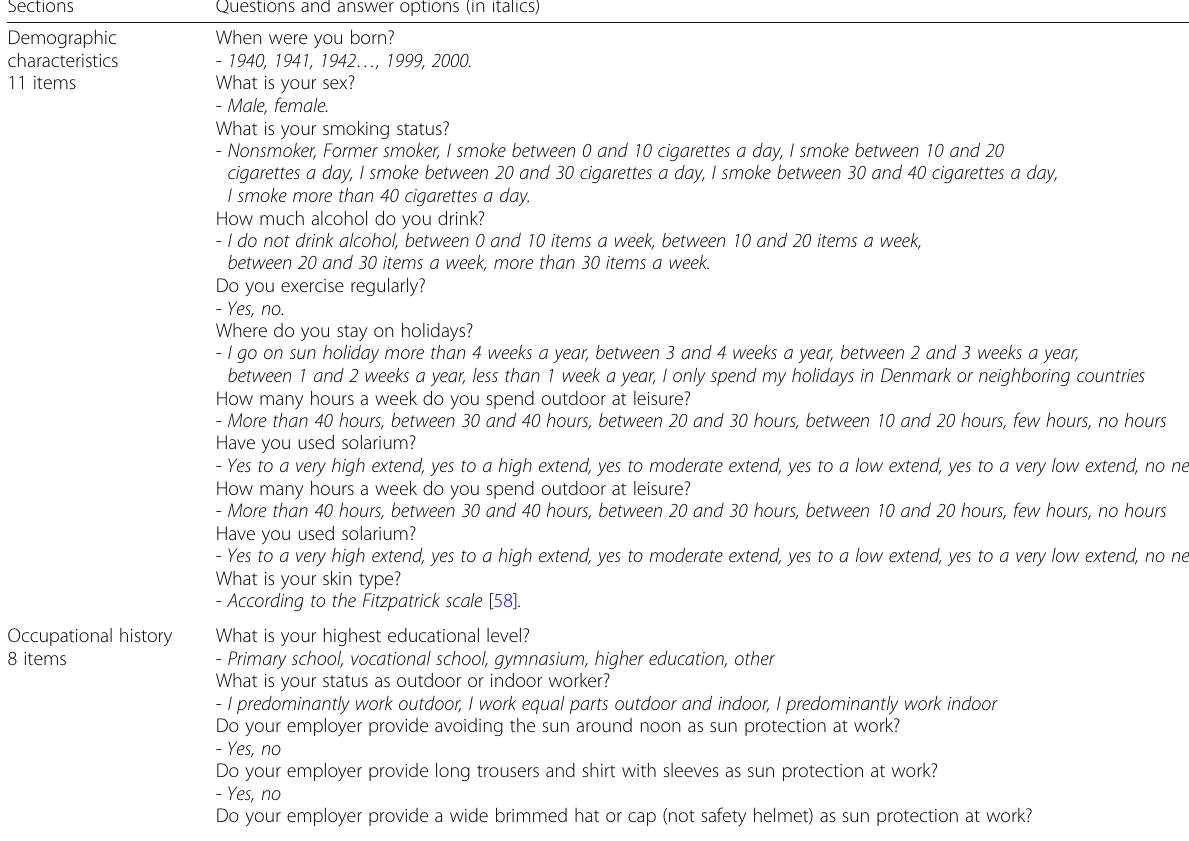
Table 4 Study questionnaire items divided into sections